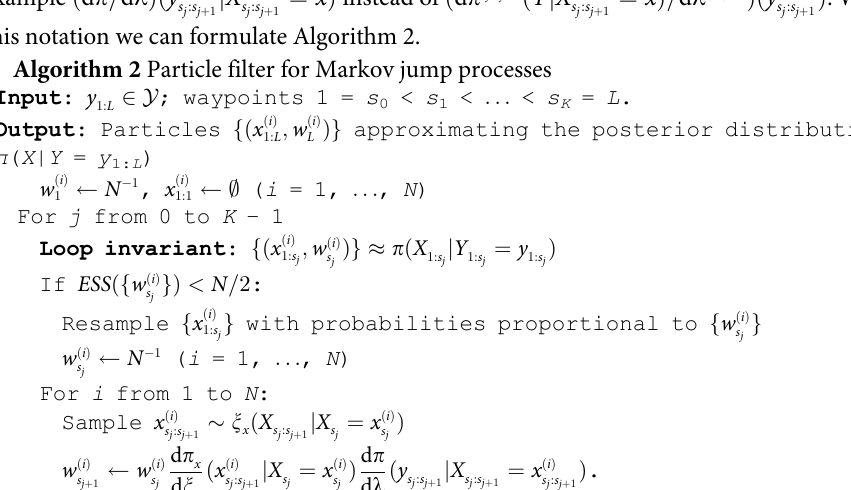
Algorithm 2 Particle filter for Markov jump